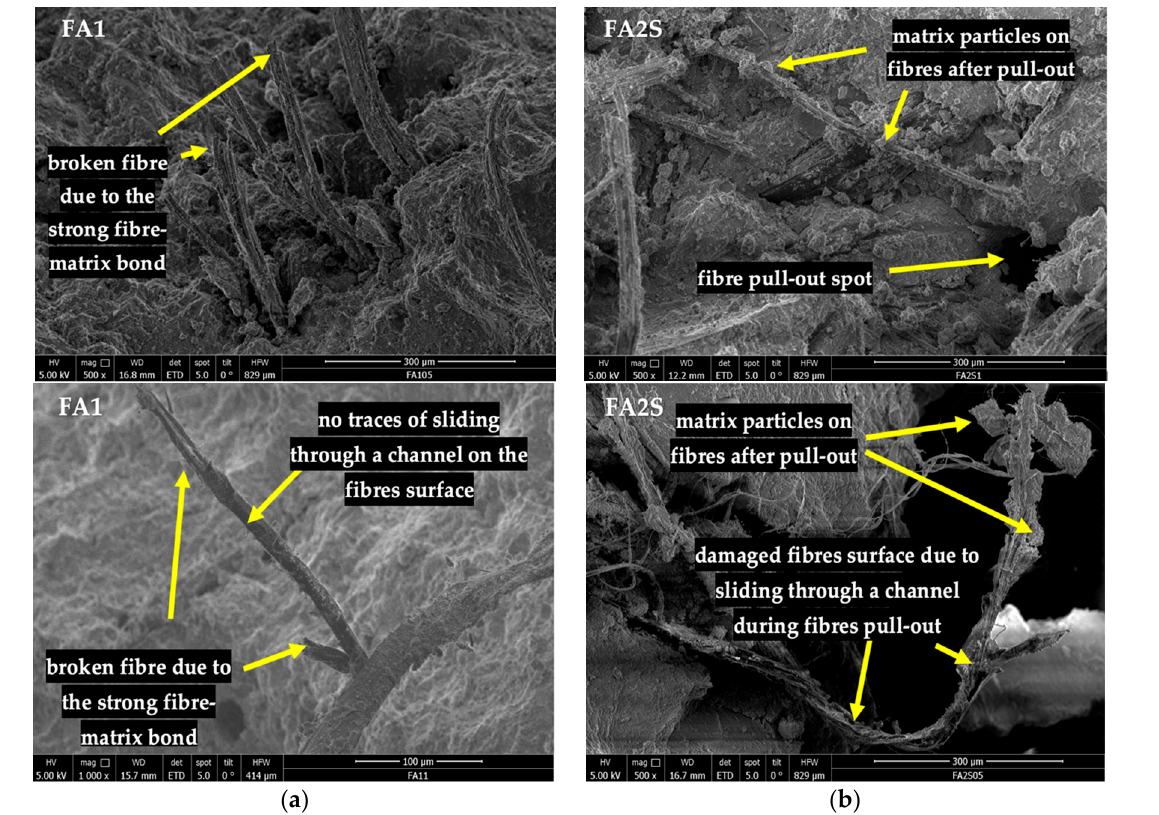
Figure 8. SEM images of fracture surfaces of fibre-reinforced AA mortars after accelerated carbonation for: ( a ) fly-ash-based AA mortar (FA1); ( b ) fly-ash-and-GBFS-based AA mortar (FA2S).